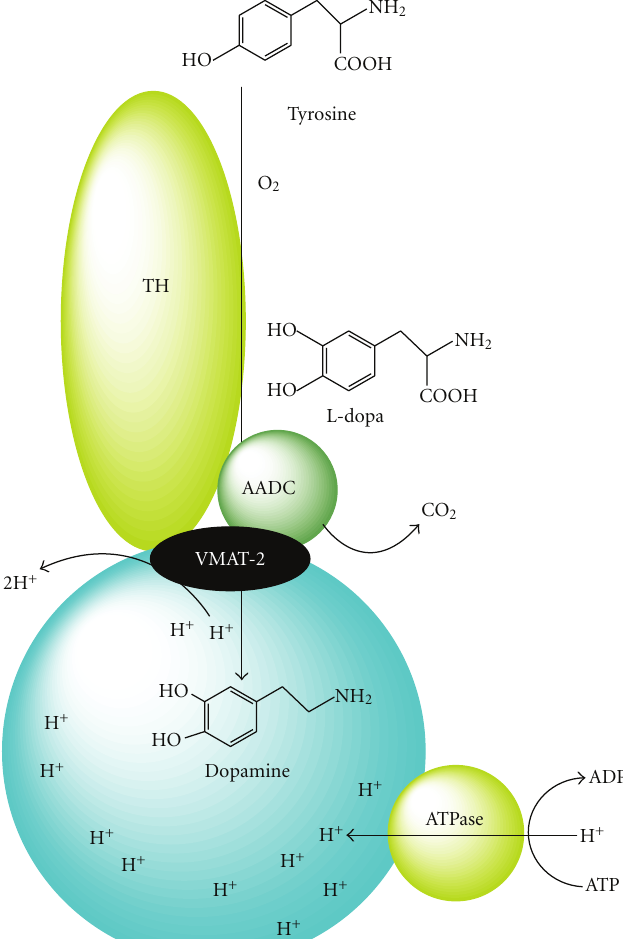
Figure 1: Dopamine synthesis. Synthesis of dopamine catalyzed by tyrosine hydroxylase (TH) and aromatic amino acid decarboxylase (AADC), which are both associated with the vesicular monoaminergic transporter-2 (VMAT-2). converted to homovanillic acid catalyzed by